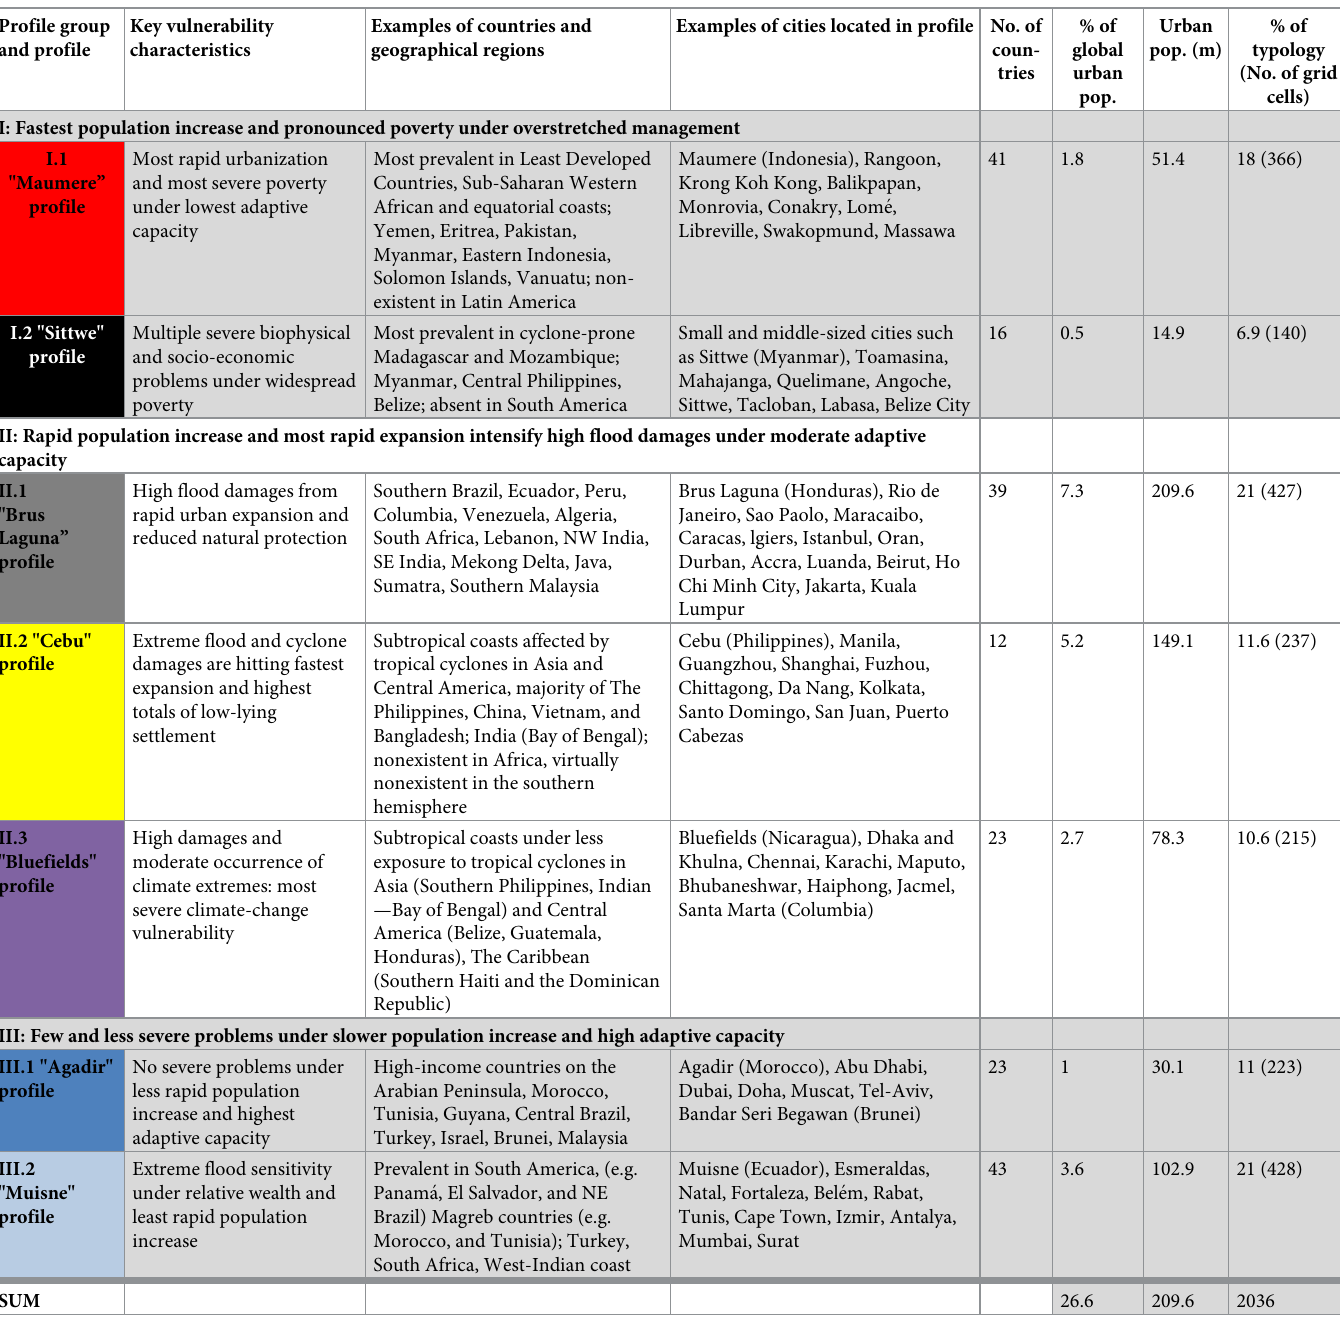
Table 2. Vulnerability profiles—Key characteristics, city examples, and geographic